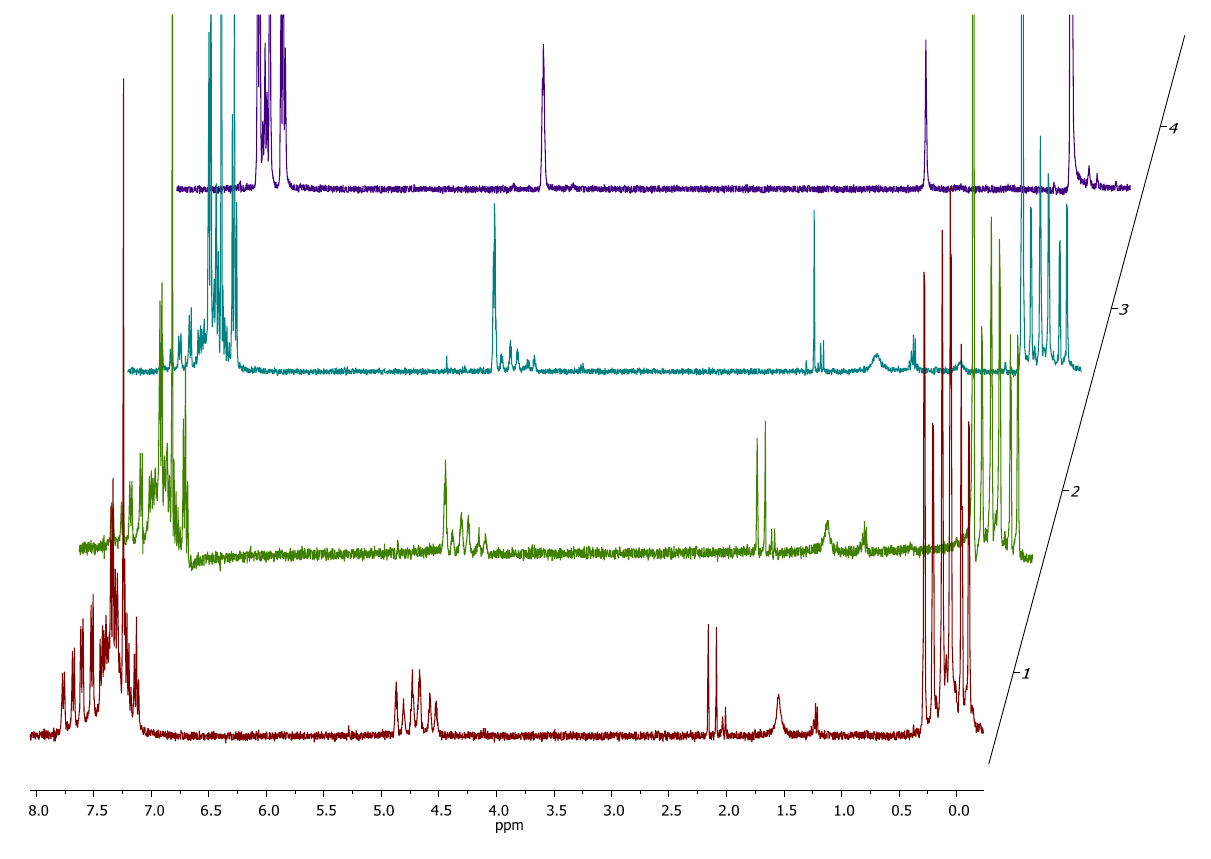
Figure 1. 1 H NMR-spectra of initial compound (violet), after 1 h from the beginning of reaction (turquoise), after 2 h (green) and after 4 h (burgundy).